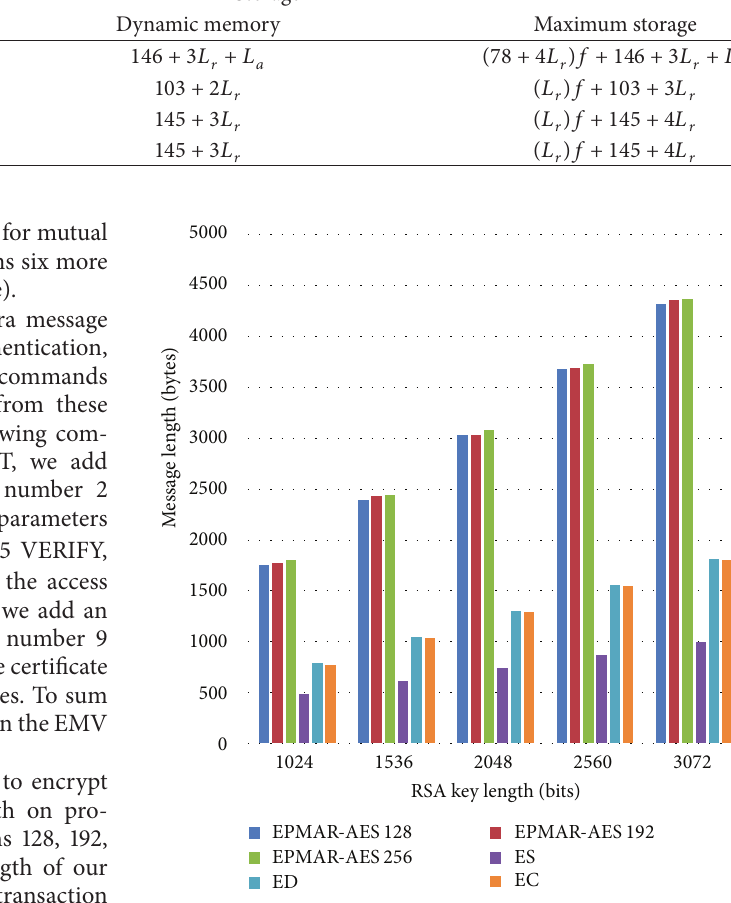
Figure 10: Comparison of message lengths—offline